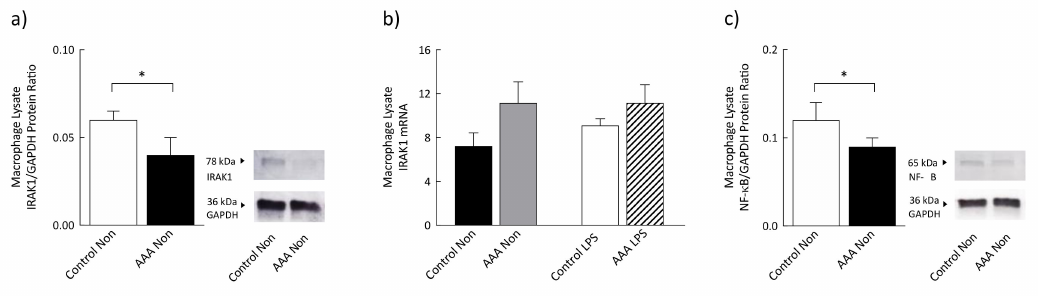
Figure 5. Protein ( a ) and mRNA transcript levels of interleukin-1 receptor-associated kinase 1 (IRAK1) ( b ) and phosphorylation levels of the p65 protein subunit of NF- κ B ( c ) in control and AAA monocyte-derived macrophages. Values are mean ± SEM. * p <